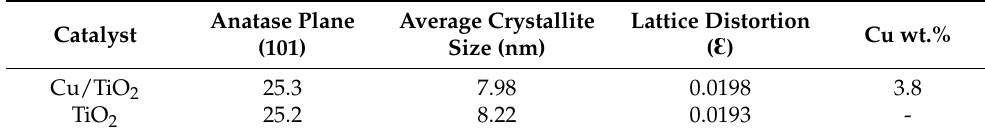
Figure 3. SEM images of catalysts ( a ) Cu/TiO 2 and ( b ) TiO 2 . Transmission electron micrographs (TEM) and high-resolution transmission electron micrographs (HRTEM) for the synthesized catalysts are shown in Figure 4. Both materials, Cu/TiO 2 and TiO 2 , exhibit crystalline structures of irregular shapes and sizes between 7 and 10 nm, as can be seen in Figure 4a,c, which is in agreement with the XRD analyses during the estimation of the average anatase crystal size. HRTEM images shown in Figure 4b,d exhibit parallel lines that are related to the distance “ d ” between two planes (101) of anatase at a value of 0.35 nm [42], which is the preferential growth direction of the crystals. These images confirm the high crystallinity and well-defined structures of the